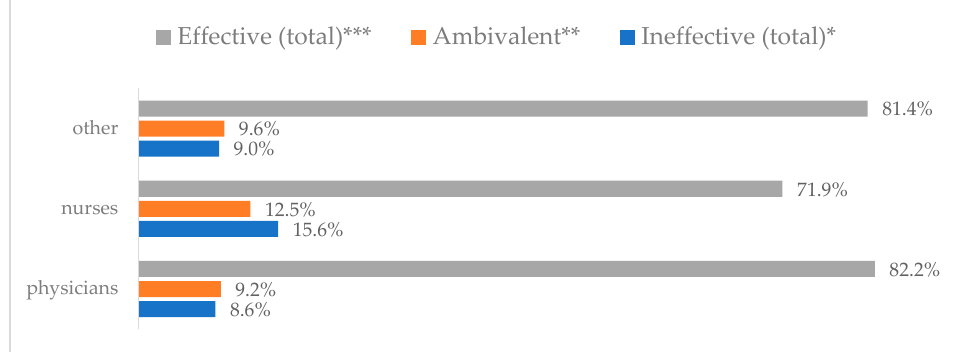
Figure 19. Avoiding contact with sick people to prevent influenza virus infection by profession ( N = 905). *Sum of responses: completely ineffective, ineffective, rather ineffective; **Response: neither ineffective nor effective; ***Sum of responses: rather effective, effective, completely effective.